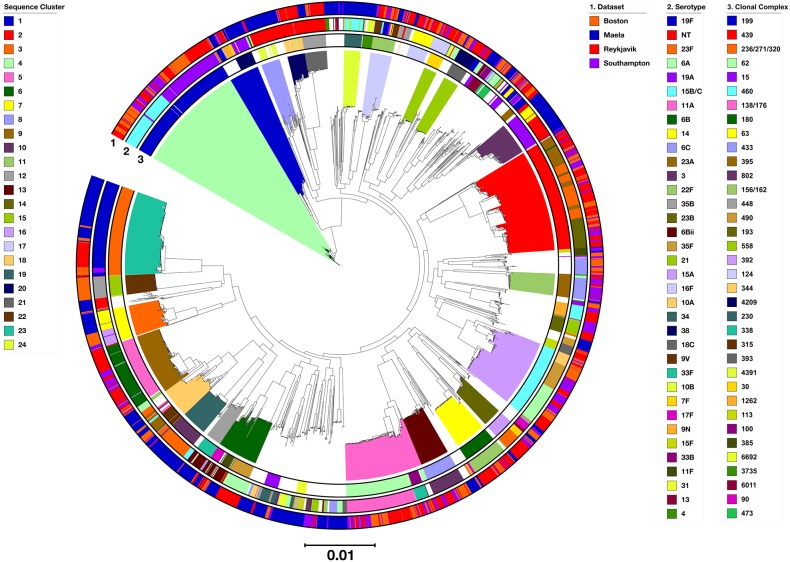
Phylogenetic tree representing the relationships among all 3,118 pneumococci, constructed based on the concatenated sequence alignment of 558 supercore genes. Clades were colored according to hierBAPS sequence cluster. Outer rings were annotated and colored as depicted in the legends. The serotypes and CCs represented by >10 and >20 genomes, respectively, were annotated here.